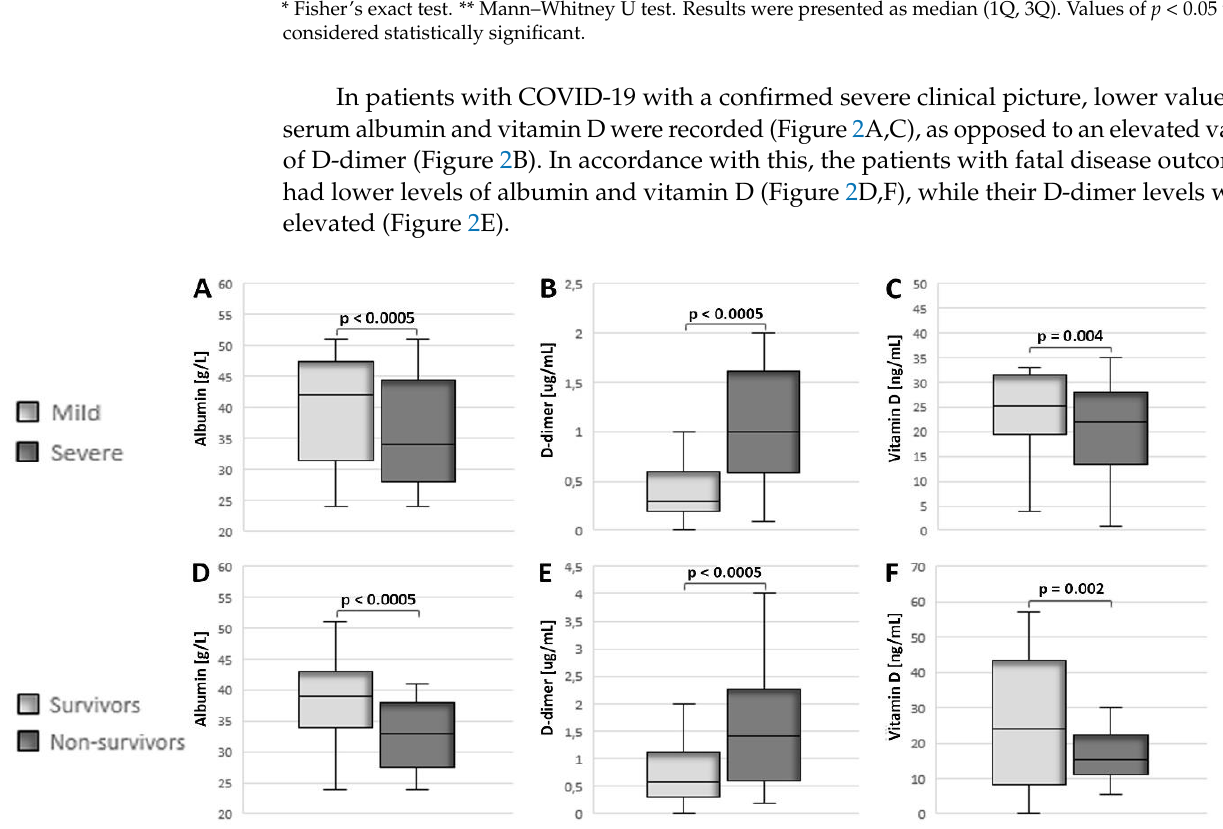
Table 1. Clinical and demographic characteristics of patients with COVID-19. The serum values of the examined biochemical parameters were obtained from blood samples immediately after admis- sion to the hospital for treatment, while other data were obtained from the medical history (n = 288). Variables